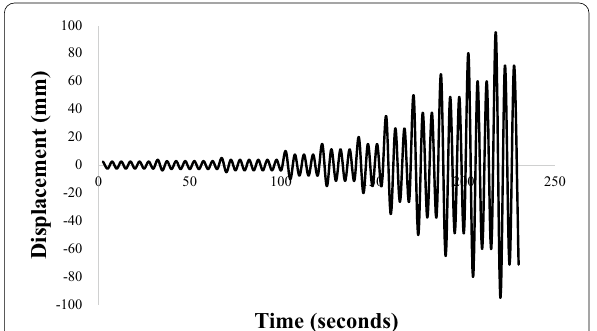
Fig. 7 Loading protocol for shear wall